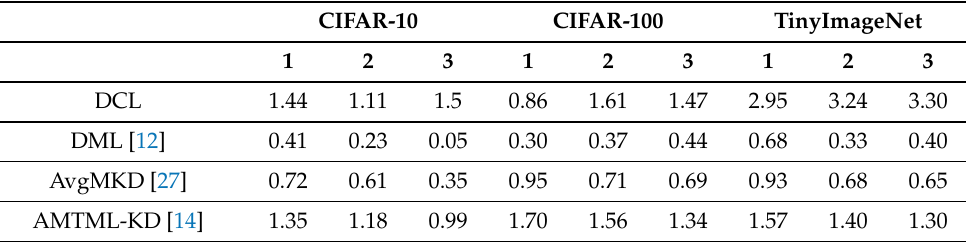
Table 3. A comparison between state-of-the-art distillation methods and DCL on CIFAR-10, CIFAR-100, and TinyImageNet. The values denote the accuracy difference between the baseline model and the distillation model. CIFAR-10